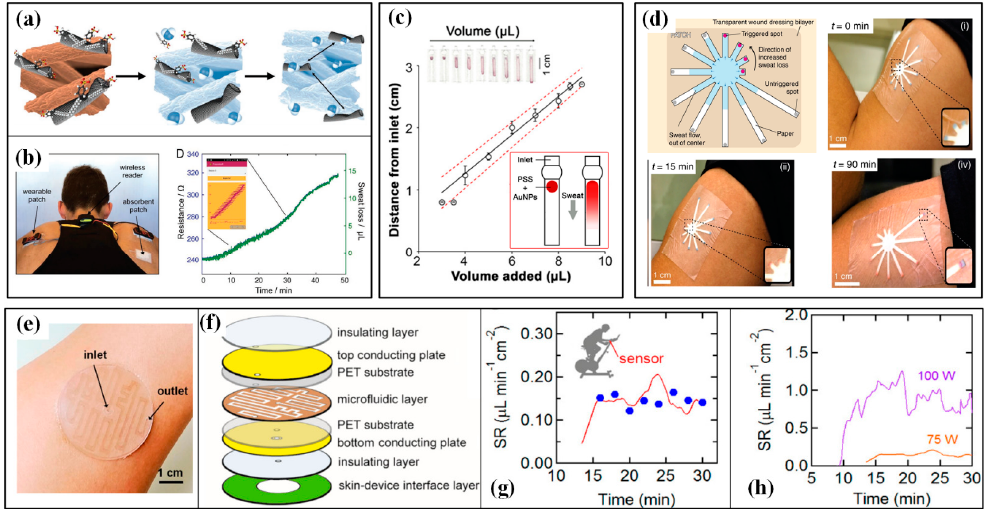
Figure 15. The wearable sweat loss sensors and their applications in sport monitoring: ( a ) the sweat-induced increment in the electrical resistance of CNT-doped conductive paper and ( b ) the monitoring of sweat loss during cycling sports [156] ; ( c ) the simultaneous colorimetric detection of sweat volume [157] ; ( d ) the mass-customizable dermal patch for calorimetrically quantifying sweat rate [158] ; ( e ) the microfluidics-based capacitive sweat rate sensor, ( f ) its schematic diagram and obtained results ( g ) when comparing with Macroduct (blue dots ) and under ( h ) different cycling power [162] . Reproduced with permissions from Wiley (2019)[156]. Reproduced with permissions from American Chemical Society (2021)[157]. Reproduced with permissions from American Chemical Society (2020)[162].